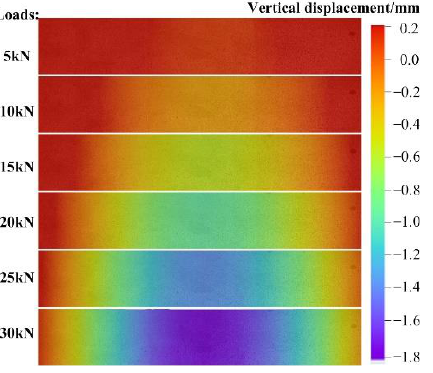
Figure 13. Vertical displacement evolution on beam surface under different loads.